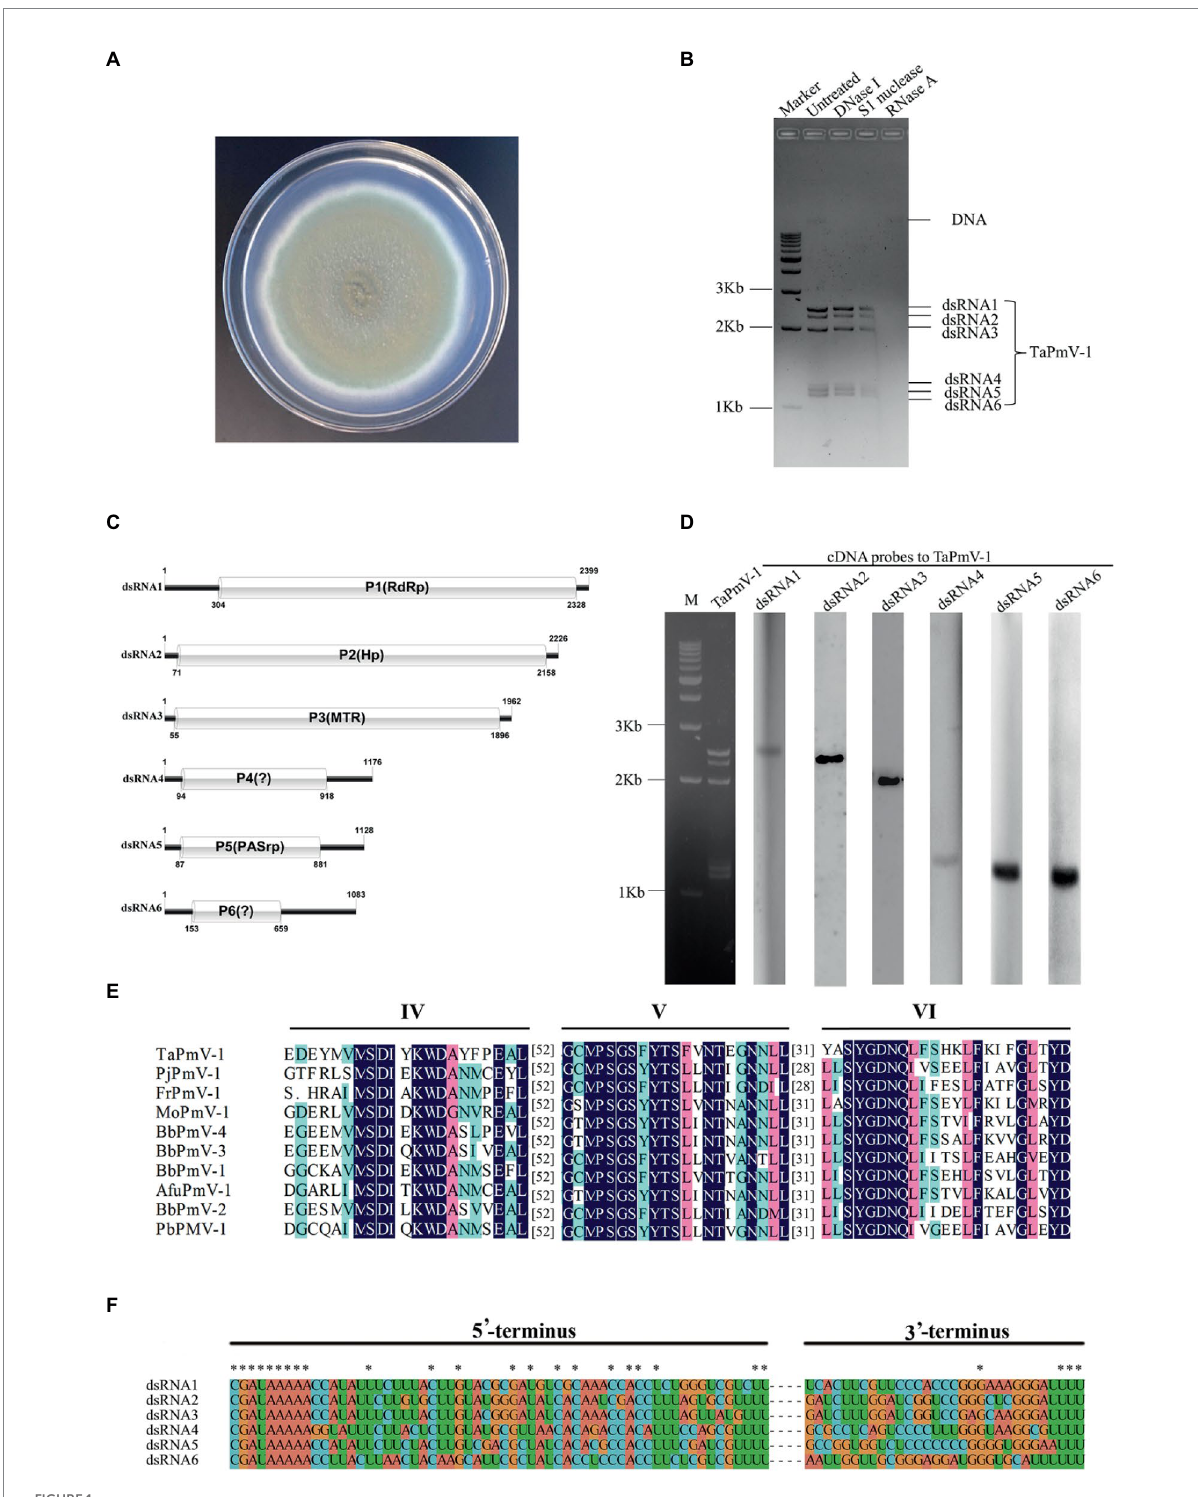
FIGURE 1 Genomic characteristics and organization of TaPmV-1. (A) Colony morphology of strain LSH3. (B) Electrophoretic profile obtained using 1% agarose gels, of dsRNA preparations extracted from the strain LSH3 following digestion with DNase I, S1 nuclease, or RNase A, and the untreated group. (C) Organization of dsRNAs 1–6 of TaPmV-1. (D) Detection of dsRNAs 1–6 of TaPmV-1 by northern blotting. Lane 1 depicts the dsRNA profile of TaPmV-1, and lanes 2, 3, 4, 5, 6, and 7 represent the individual transfers hybridized with specific probes for dsRNA1, dsRNA2, dsRNA3, dsRNA4, dsRNA5, and dsRNA6, respectively. (E) Comparison of the conserved motifs of the RdRp protein encoded by TaPmV-1 with those of other polymycoviruses. (F) Conserved sequences at the 5 ′ - and 3 ′ -termini of dsRNAs 1–6 of